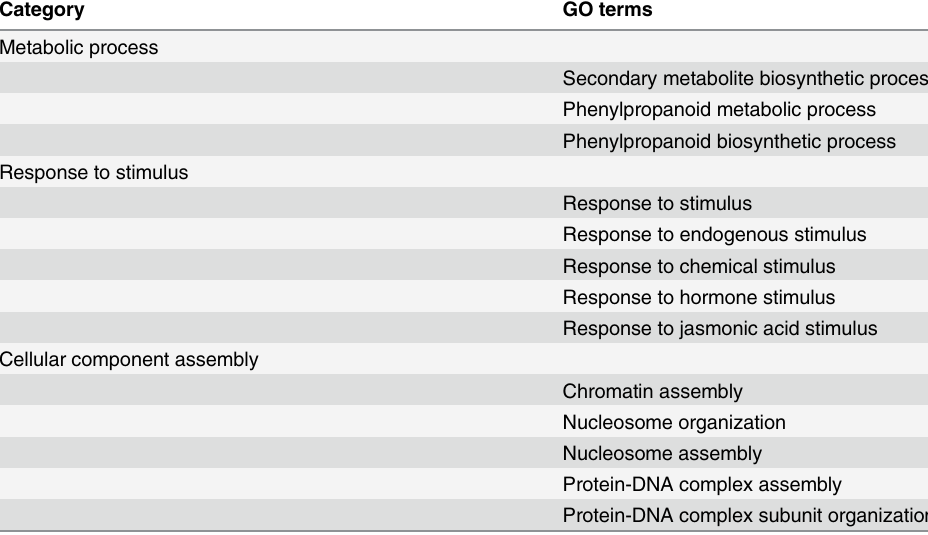
Table 4. Biological processe (BP) terms significantly affected by drought treatment in A . mongolicus leaves during 24 to 72 h